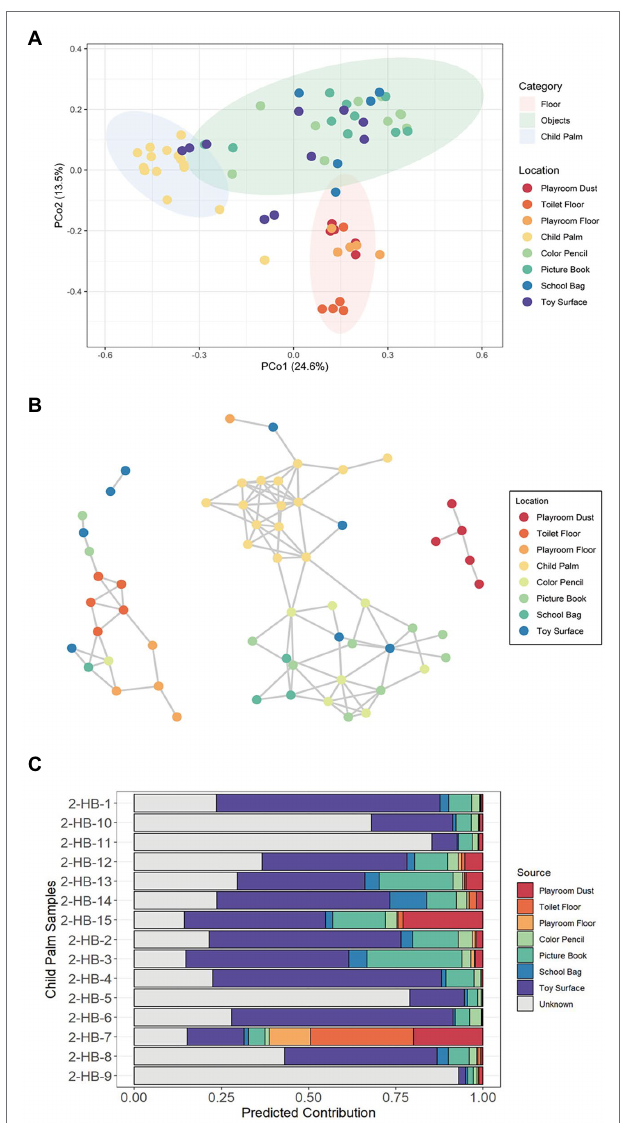
FIGURE 2 | Microbial associations between sampled sites with the inclusion of child palm samples. (A) Principal coordinates analysis (PCoA) ordination plot based on Bray–Curtis distance reveals significantly different composition of microbial species (PERMANOVA; R 2 = 0.410, p < 0.001) among the sampled sites of Kindergarten 2. Three distinct clusters corresponding to samples obtained from the floor (Playroom Dust, Playroom Floor, and Toilet Floor), hand- touched objects (Picture Book, School Bag, Toy Surface, and Color Pencil), and the child palm were formed. Each point corresponds to a sample and is colored according to the sampled site. Ellipses correspond to 95% confidence regions. (B) Inference of microbial interaction network based on inter-sample correlation in Kindergarten 2 using SPIEC-EASI based on the relative abundance of all bacterial species. Sample-to-sample interactions were stratified by the sampling site. Each node represents a sample with the color indicating the sampling site, and no samples were omitted from the network. (C) The relative contribution from each microbial “source” community to each child palm (“sink”) microbial community was estimated using